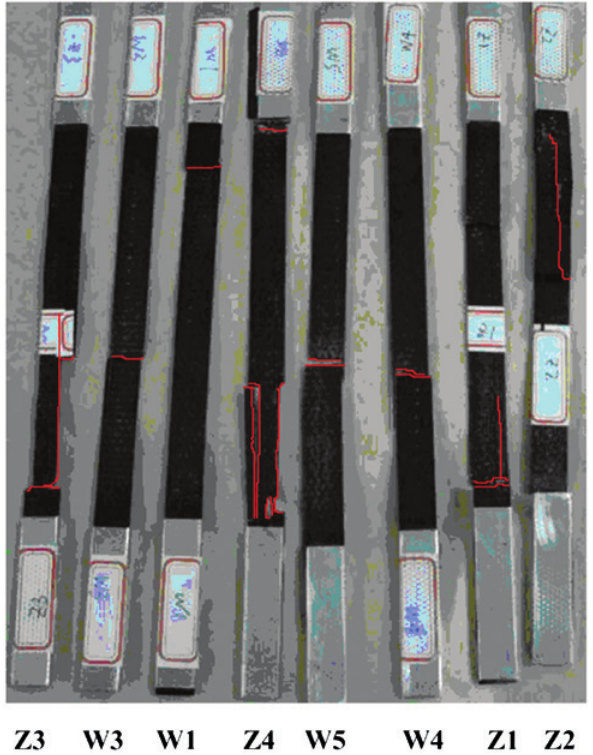
specimens with Z-pins and without 6